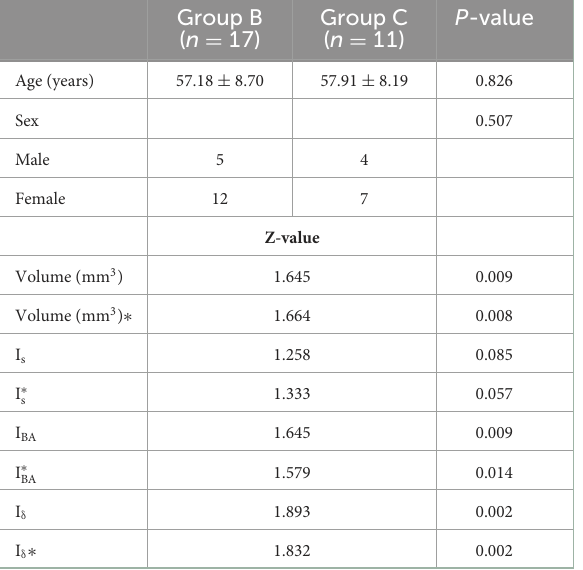
TABLE 3 Statistical results of parameters related to semi-transparent and non-translucent aneurysms in the unruptured group.